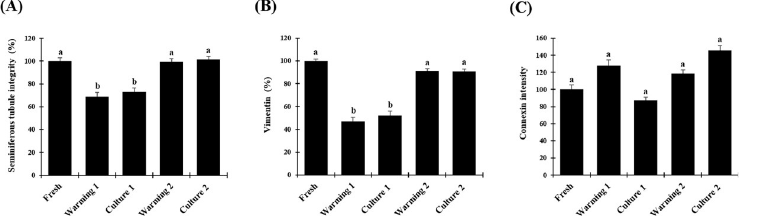
Fig 1. Morphological evaluation of vitrified testicular tissue from prepubertal domestic cats. (A) proportion of intact seminiferous tubules, (B) proportion of Sertoli cells stained with vimentin in each seminiferous tubule, (C) connexin expression relative to pixel intensity. Data are expressed as mean ± SE (n = 6 animals per treatment). Different letters above bars indicate significant statistical differences between treatments (P < 0.05). Warming 1 (tissue warmed at 37˚C), culture 1 (warming 1 followed by culture for 24h), warming 2 (tissue warmed at 50˚C), culture 2 (warming 2 followed by culture for